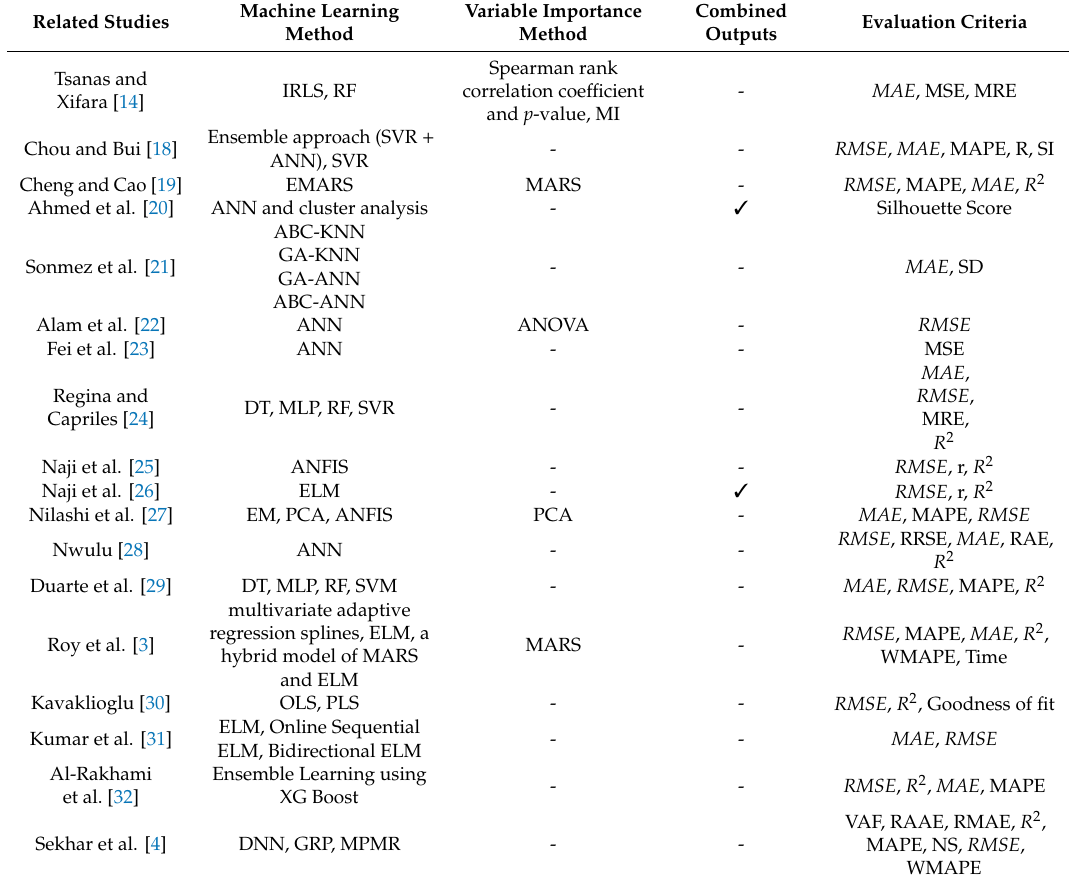
Table 1. Literature